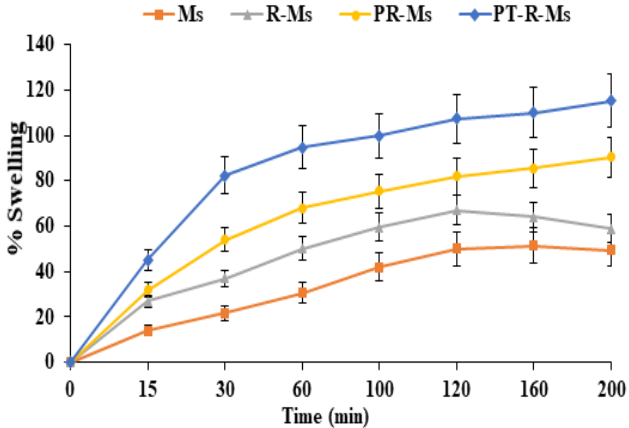
Figure 4. Swelling studies of Ms, R-Ms, PR-Ms, and PT-R-Ms. Experiments were carried out for 3 h in phosphate buffer (pH 7.4, 0.1 M). Results are expressed as mean ± SD, n = 3, p < 0.05